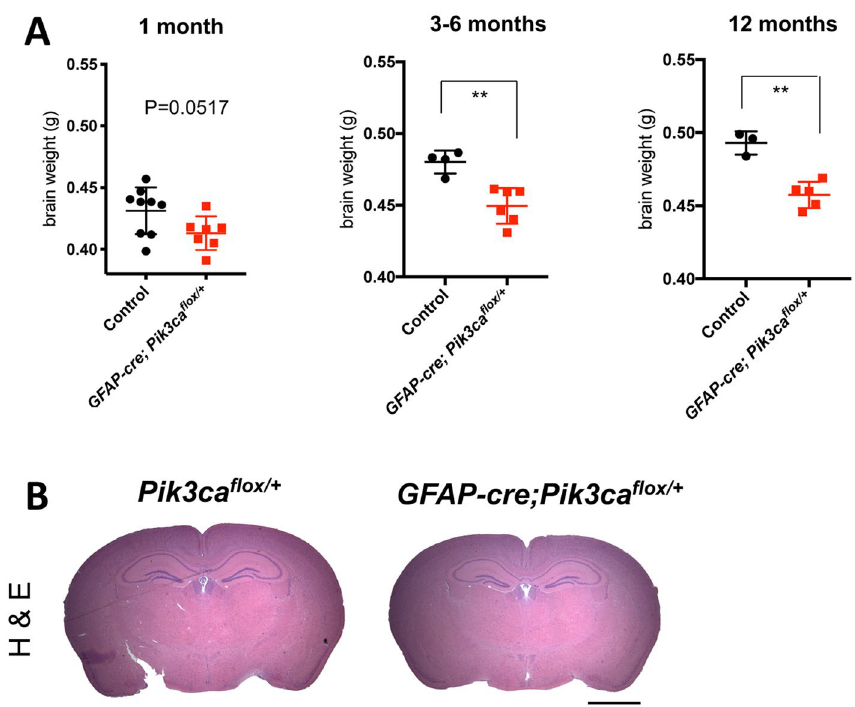
Figure 3. GFAP-cre; Pik3ca flox/ + mice have substantially reduced brain weight and size. ( A ) Brain weight of mice at different ages. Data represents mean ± SD ( n = 3–9). ** P < 0.01. ( B ) H&E staining in the indicated mice at 6 months old. Scale bar, 2